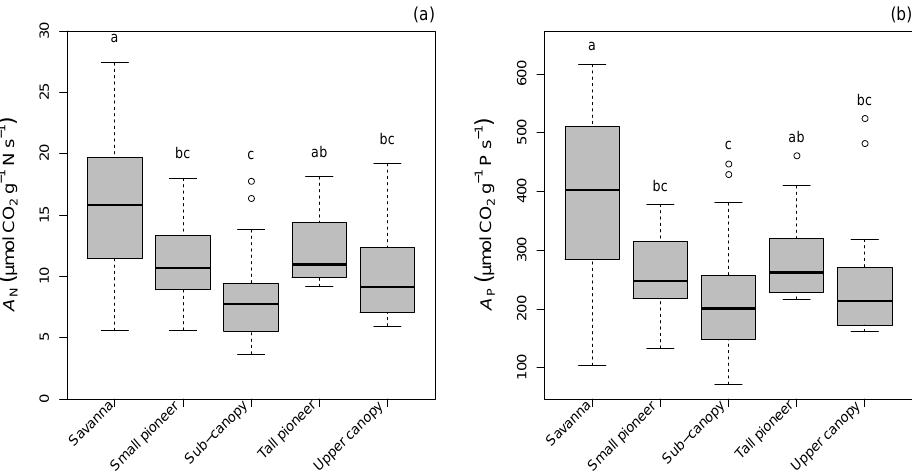
Figure 4. Boxplots of photosynthetic N use efficiency ( A N ) and P use efficiency ( A P ) by φ . Boxes which share the same letter correspond to means that were not significantly different (Tukey’s HSD on ranked values). Boxplot construction is explained in Fig.